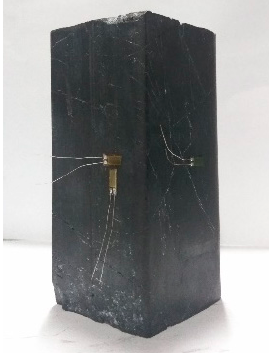
Figure 3. 50 × 50 × 100 mm coal sample for the adsorption test.